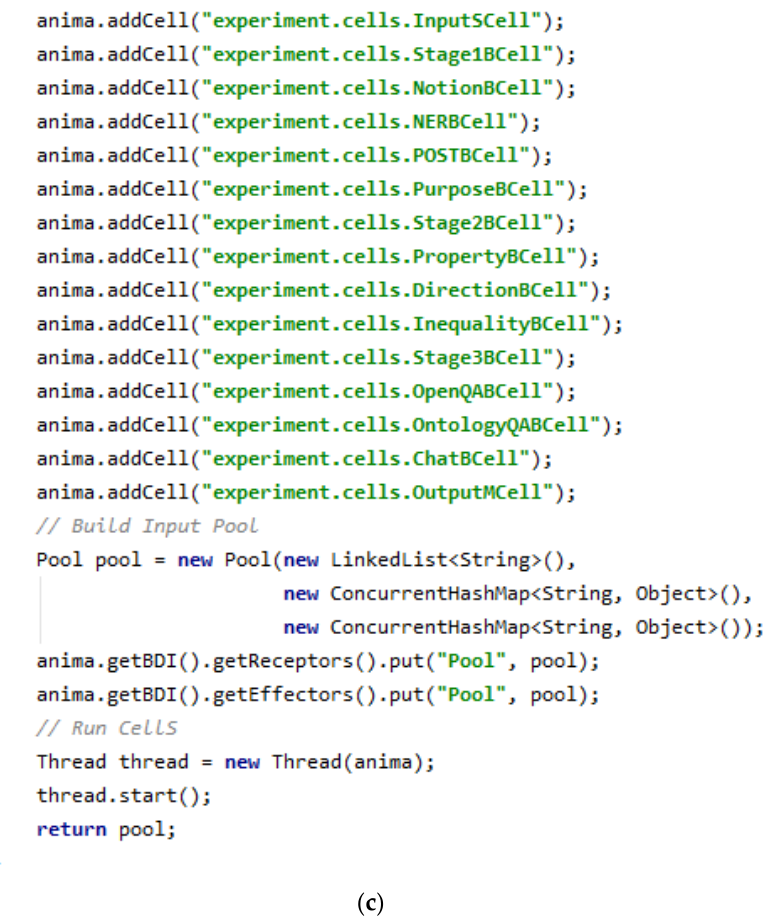
Figure 11. This is a hypothetical dialogue system using ( a ) sequential programming; ( b ) concurrent programming; and ( c ) the CellS framework.